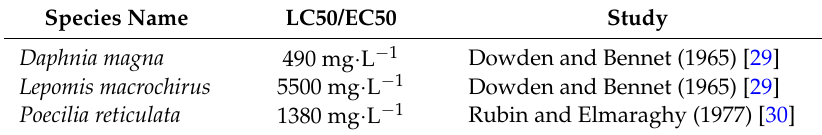
Table 7. Lethal or effective concentration for potassium nitrate in studies with aquatic organisms.